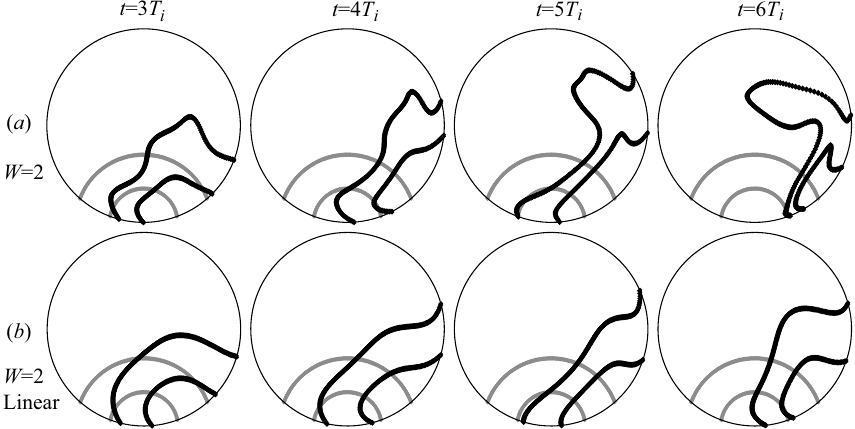
Fig. 9. Evolution of a particle cloud for B = 1 with the Wedderburn number W = 2. Row (a) is subject to nonlinear flow for the lowest vertical mode and linear hydrostatic flow for the second vertical mode. Row (b) is subject to linear hydrostatic flow for both vertical mode-one and two. Grayed points represent the initial position of particles. ( h 2 = 1, h 3 =